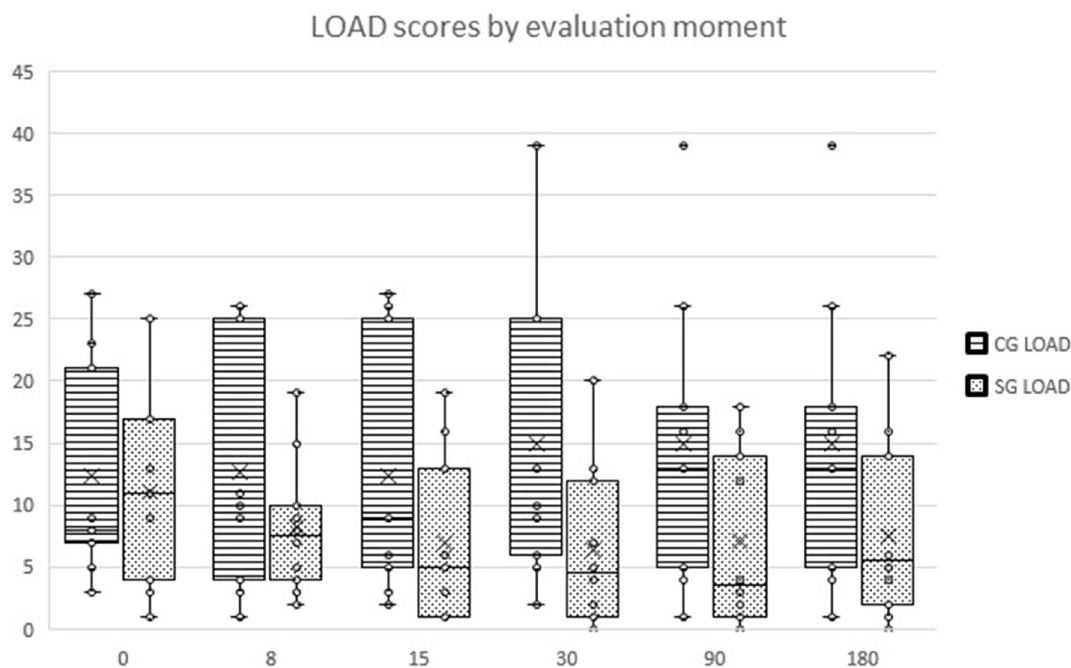
Figure 2. Overall evolution of Liverpool Osteoarthritis in Dogs (LOAD) in the control group and treatment group. Box plots represent the median, 25th and 75th percentiles, and whiskers represent 10th and 90th